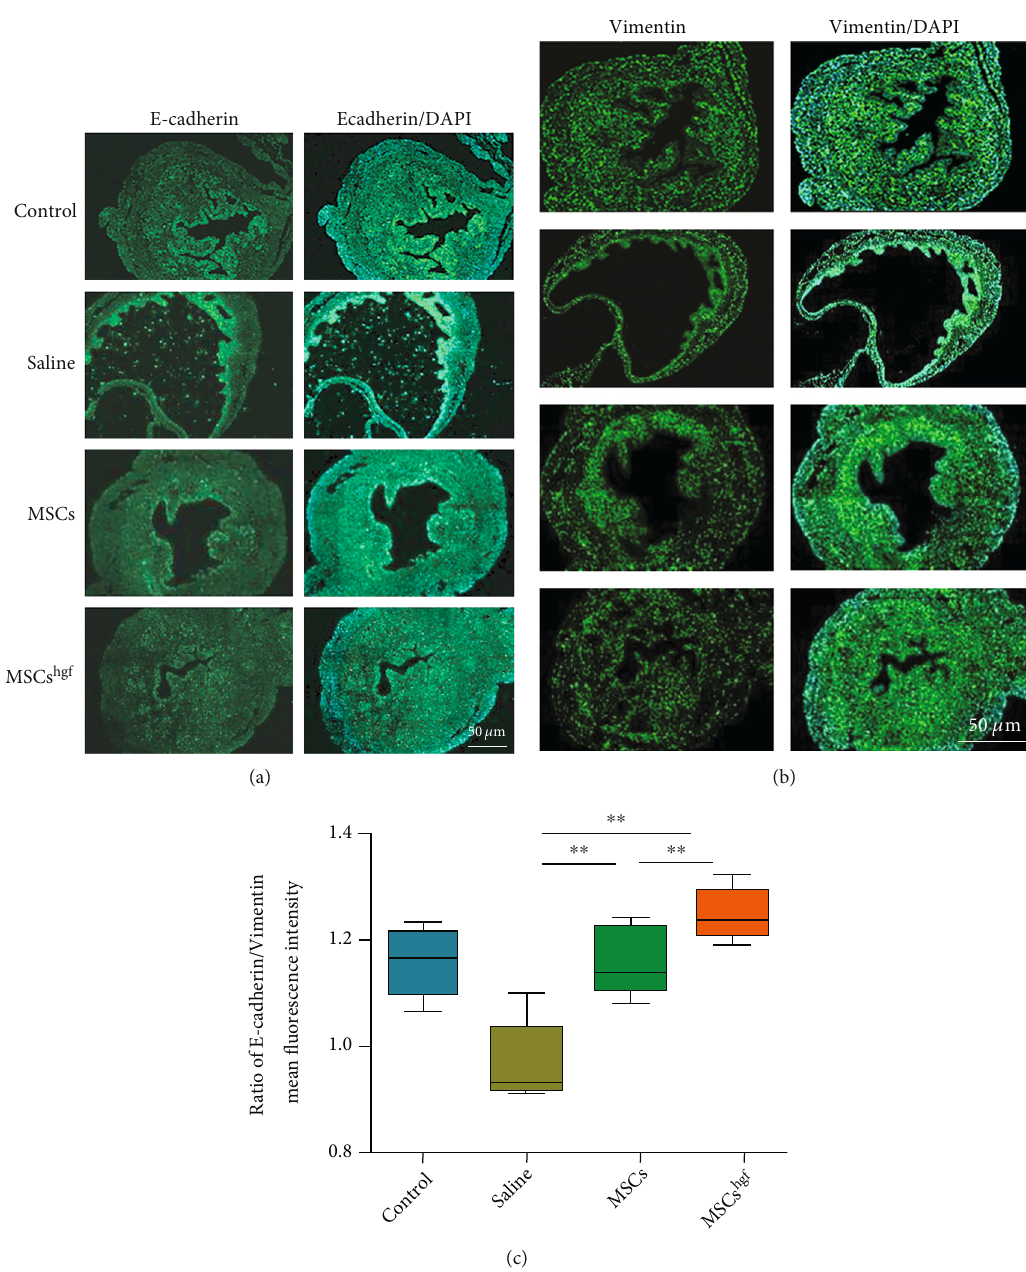
Figure 5: HGF gene-transfected MSCs promote the degree of the MET process in damaged endometrium. (a) Representative images of E- cadherin immuno fl uorescence in each treatment group. (b) Representative images of vimentin immuno fl uorescence in each treatment group. (c) The ratio of E-cadherin and vimentin intensity in each treatment group ( ∗∗ P < 0 : 01 , n = 3